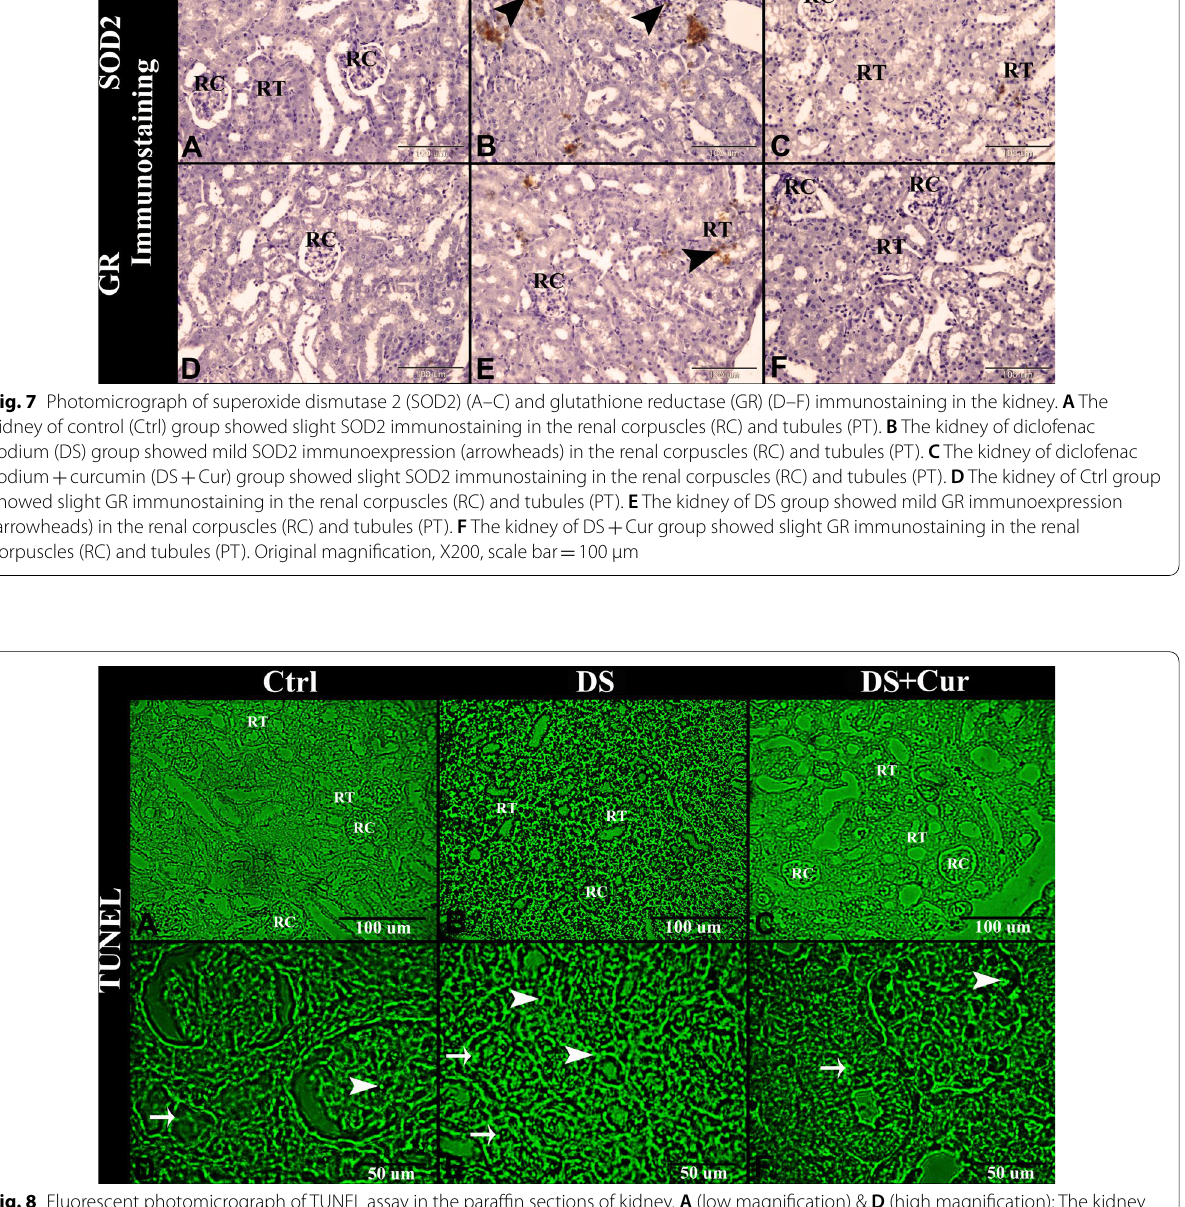
curcumin (DS Cur) group + +